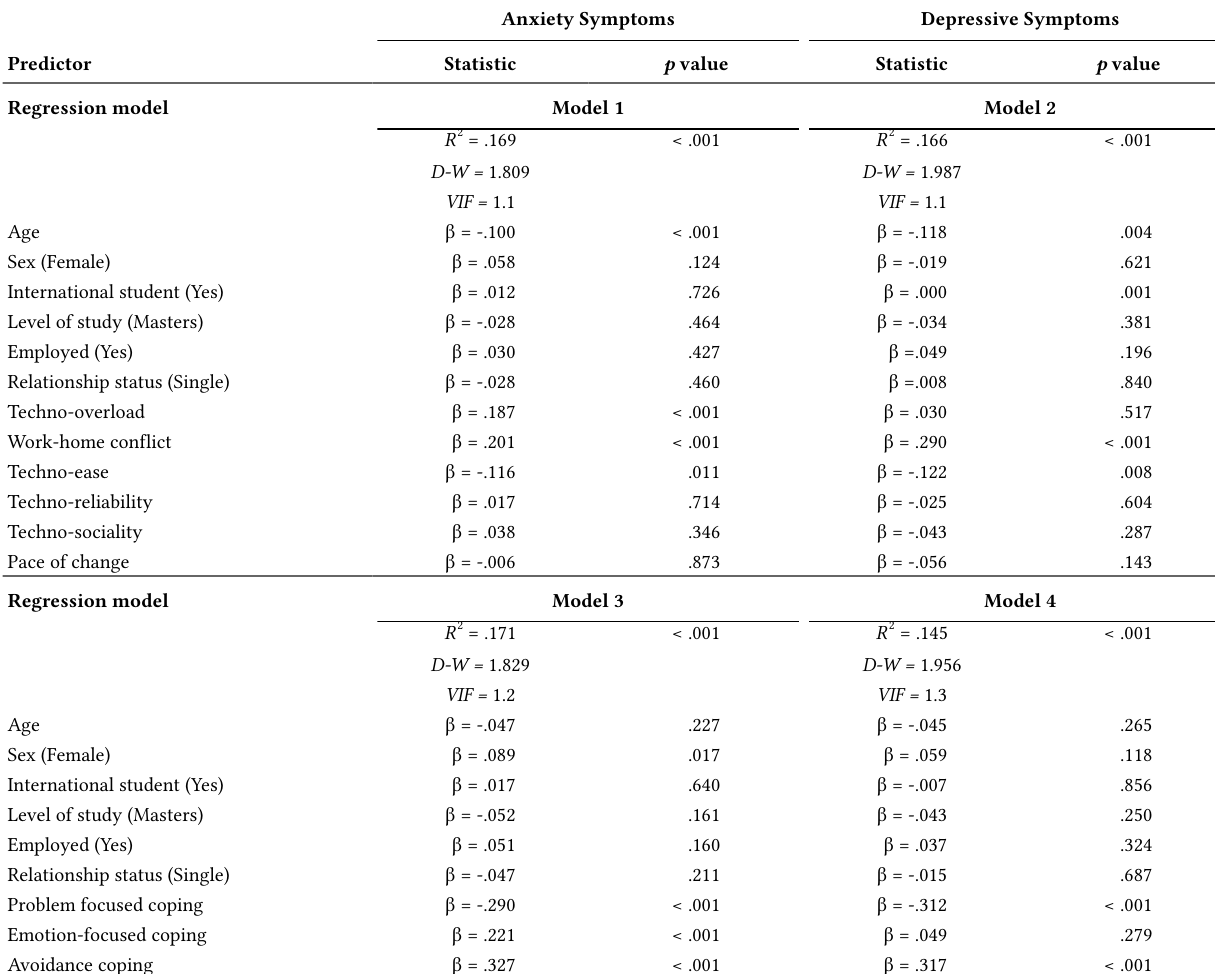
Regression Analyses For the HADS Anxiety and Depression